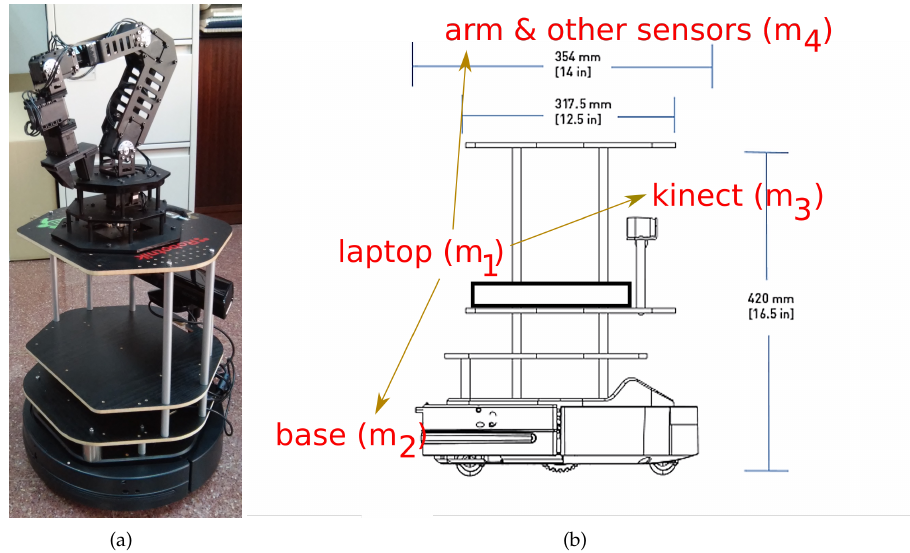
Figure 3. ( a ) CRUMB: a Turtlebot-2 robot composed of a Kobuki mobile base, a manipulator mounted on top and room for placing a laptop and other possible sensors [47]. ( b ) Star-like topology of the data transmissions in this robot, where the laptop acts as the central